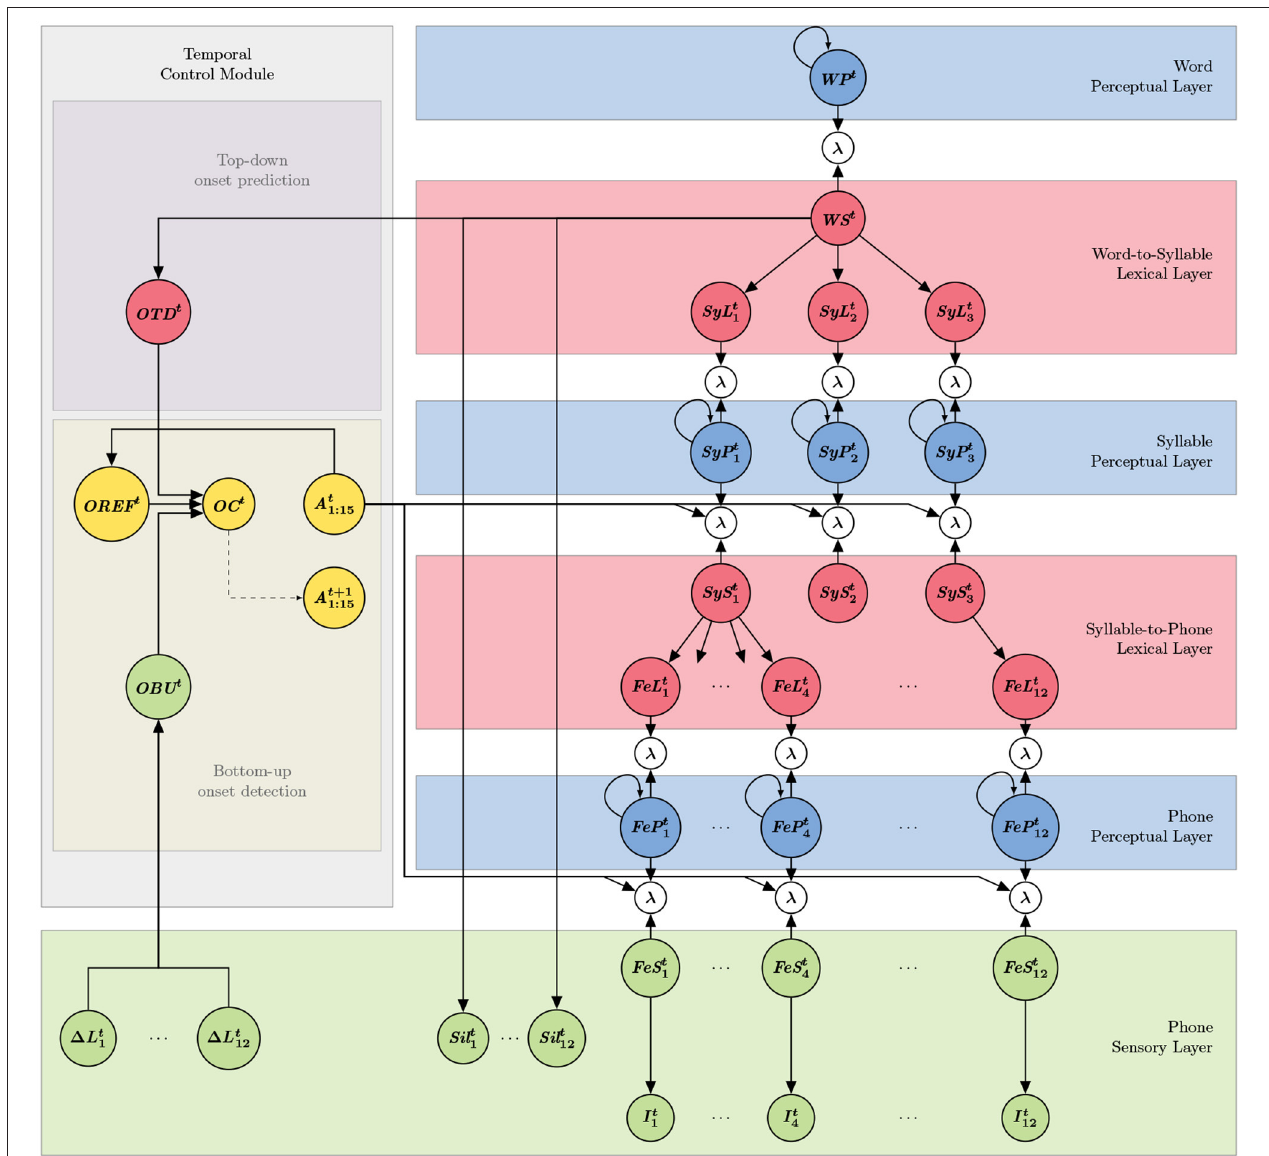
FIGURE 1 | Graphical representation of the COSMO-Onset model. Variables of the model are represented as nodes (a summary of variable names and their interpretation is available in Table 1 ). Subscripts indicate position in sequential parsing of the input into linguistic unit, and superscripts indicate time instant. For instance, SyP t 1 is the variable related to the first syllabic decoder at time t . Probabilistic dependencies between variables are represented by arrows: there is an arrow from node X to node Y if X is a “parent node” of Y , that is to say, X appears as a conditioning variable of Y in a term [e.g., the arrow from SyS t 1 to FeL t 1 represents the term P ( FeL t 1 | SyS t 1 )]. Self-looping arrows denote dynamical models, that is to say, a variable that depends on the same at the previous time step [e.g., there is a term P ( WP t | WP t − 1 )]. The dotted arrow between node OC t and node A t + 1 1 : 15 is not a probabilistic dependency, and represents instead a decision process (i.e.,